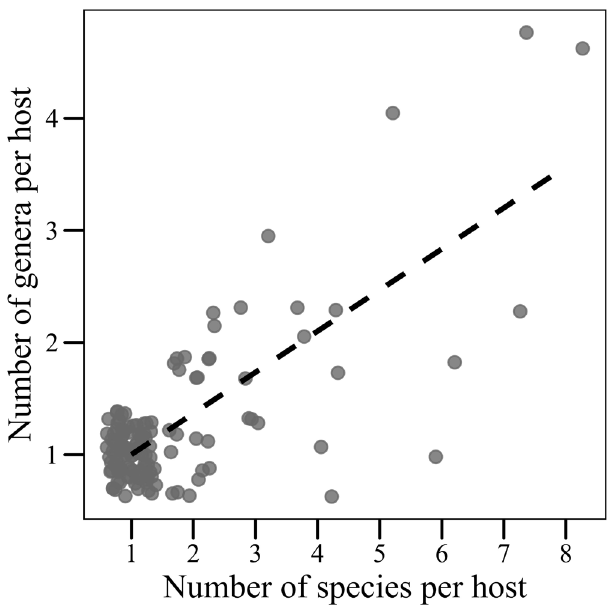
Fig 1 . Scatter plot between the number of genera and the number of species per host for 214 species of Corotocini beetles. The tendency line was estimated using the least square linear regression. The data points were jittered due to